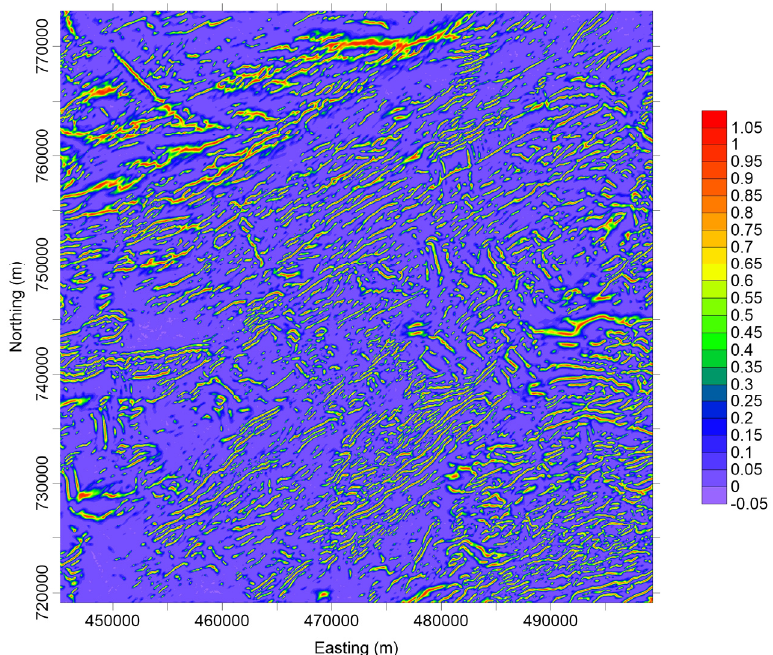
Figure 5. SF map of the study area.